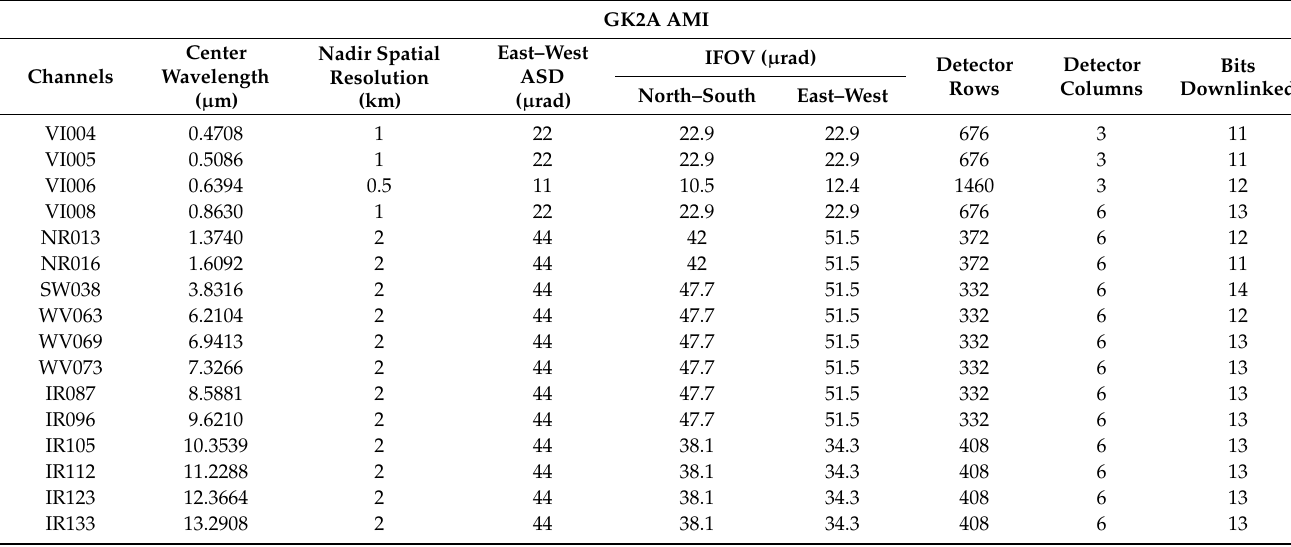
ASD = angular sample distance (east–west (EW) interval at which samples are collected at standard scan rate); north–south (NS) ASD = NS Instantaneous Field of View (IFOV) (NS interval at which samples are collected at 100% fill factor); resolution = pixel spacing of final image after resampling (1 km = 28 µ